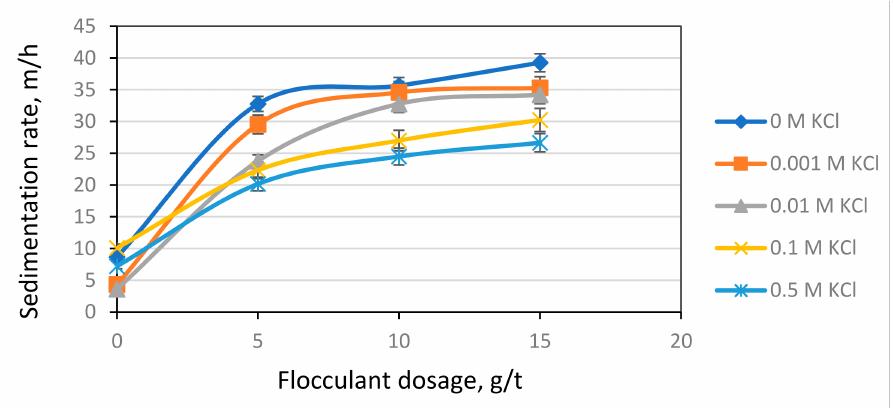
Figure 7. Sedimentation rate in relation to the flocculant dose Magnafloc-1011 in industrial water.